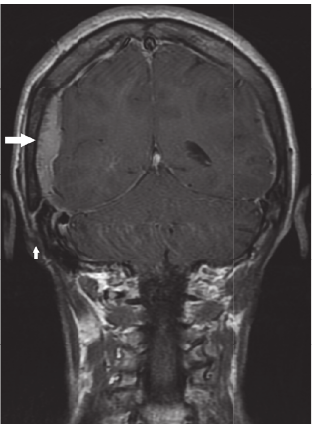
Figure 2: Postcontrast, T1 weighted coronal MRI of brain, showing extension of right side mass (large arrow) through the squamosal suture (small arrow).